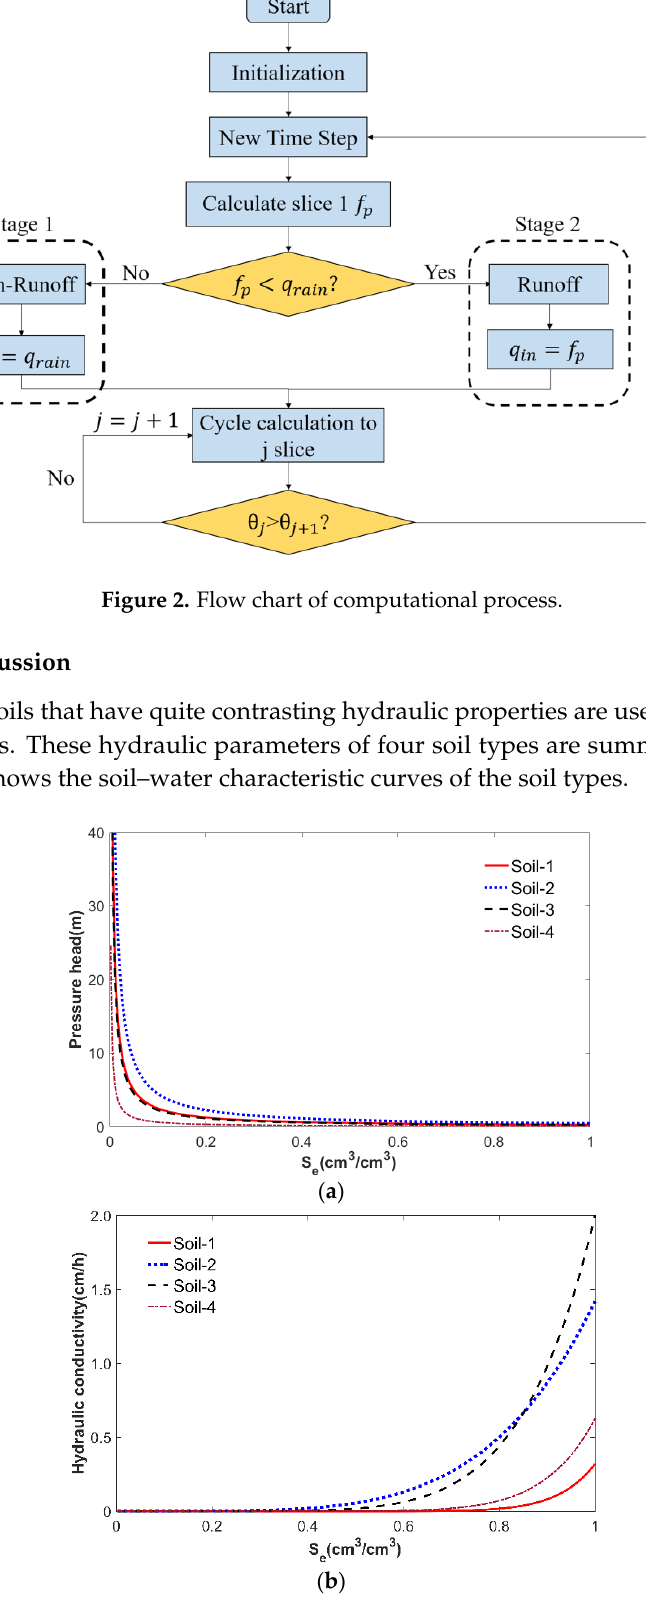
Figure 3. Soil–water characteristic curves of different soil types. ( a ) Pressure head curves; ( b ) Hydraulic conductivity curves.